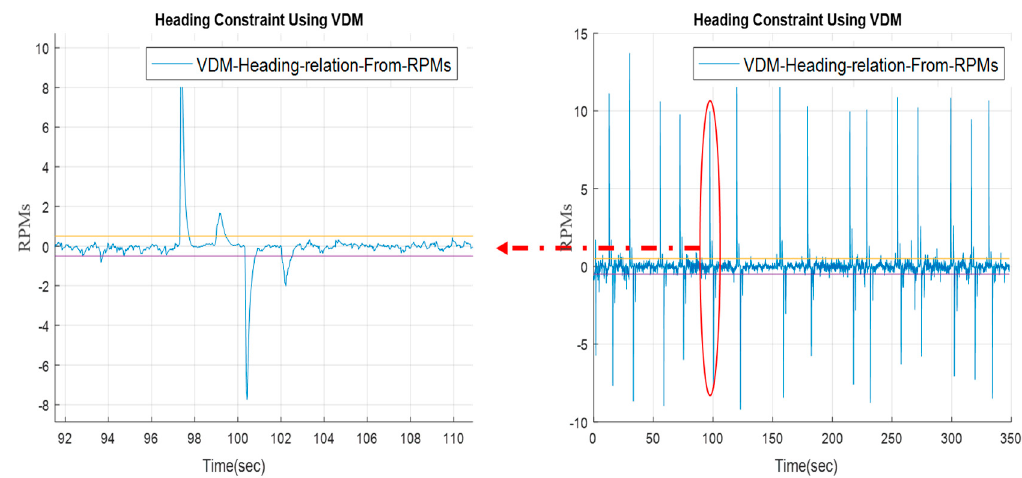
Figure 6. Quadcopter Vehicle dynamic model heading RPMs relation and upper and lower heading constraint threshold. Within the heading constraint limits there is no heading change.